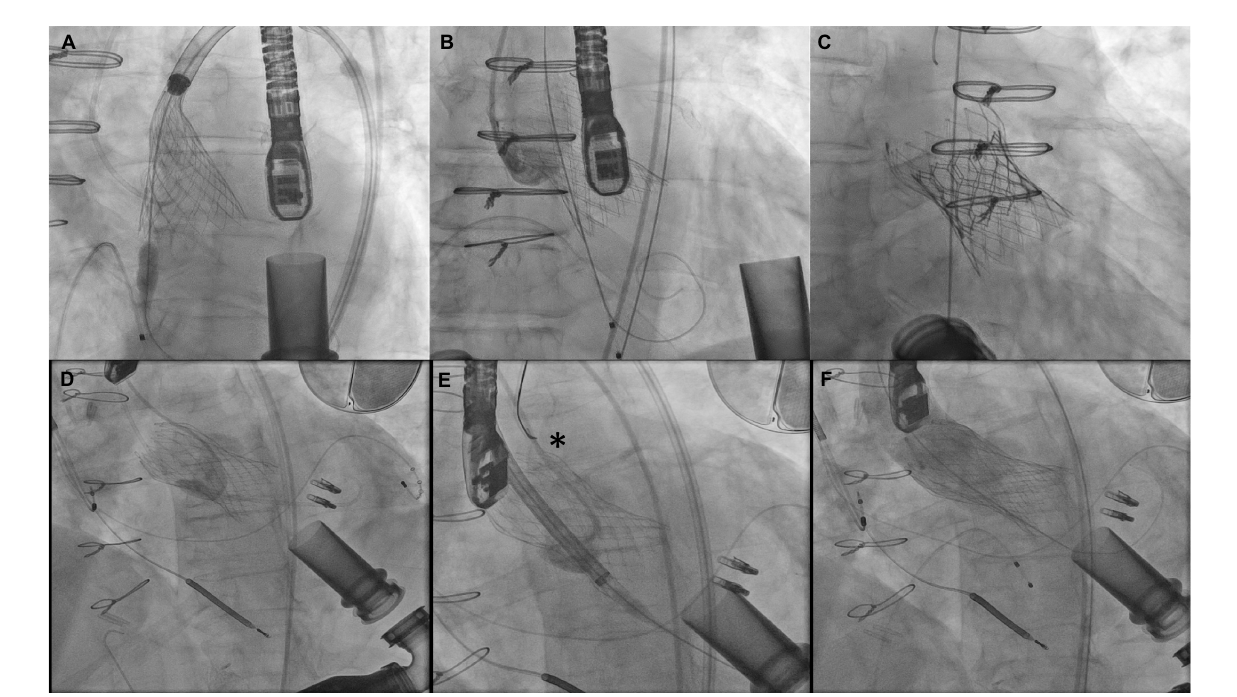
FIGURE 9 (A–C) Attempted Evolut R implant with ventricular migration immediately after release stabilized with 29 mm Sapien 3 implant inside the malpositioned Evolut. (D–F) Ventricular migration of Evolut R valve in another patient with repositioning using a gooseneck snare (asterisk) and implantation of a second Evolut R inside with post dilation reducing aortic insufficiency to